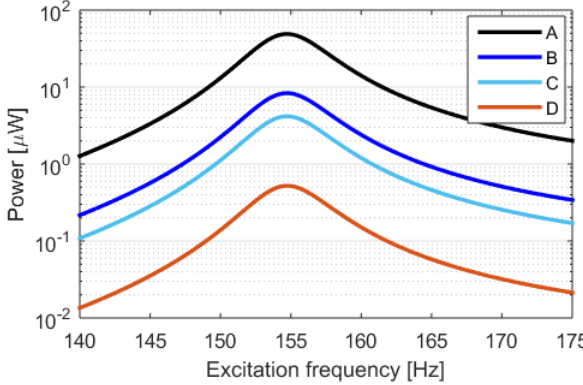
Figure 3. Power output of the four PEHs with different geometries, tuned to the same resonance.